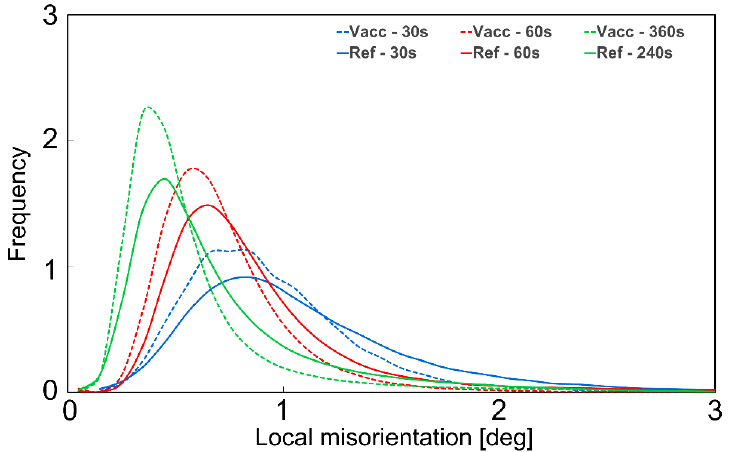
Figure 12. Local misorientation distributions of the refractory ballast (solid lines) and vacuum- sintered (dashed lines) samples.